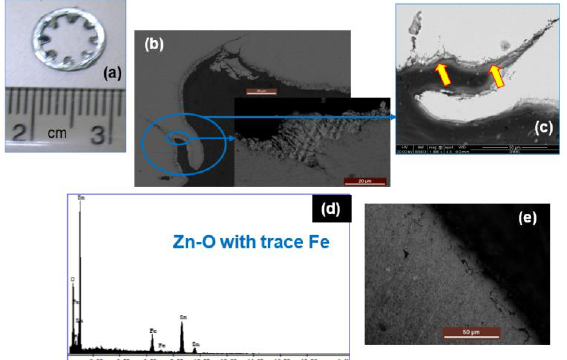
Figure 8: (a) As-received photograph of the plain Figure 9: (a) As-received photograph of the spring washer of washer of Figure 3a,c showing the corrosion, (b) Figure 3a,d showing the corrosion, (b,c) respective optical EDS analysis result for the corrosion debris sitting and SEM BSE image showing corrosion products along an on the surface, (c) etched optical micrograph edge in the cross-sectional view, (d) EDS analysis result for along an edge in the cross-sectional view of the the corrosion product shown in Figure 9c, (e) etched optical severely corroded region showing uniform micrograph along an edge showing severe pitting. corrosion and no penetration of the corrosion product deep into the structure. Table 2: Chemical compositions of investigated failed (corroded)